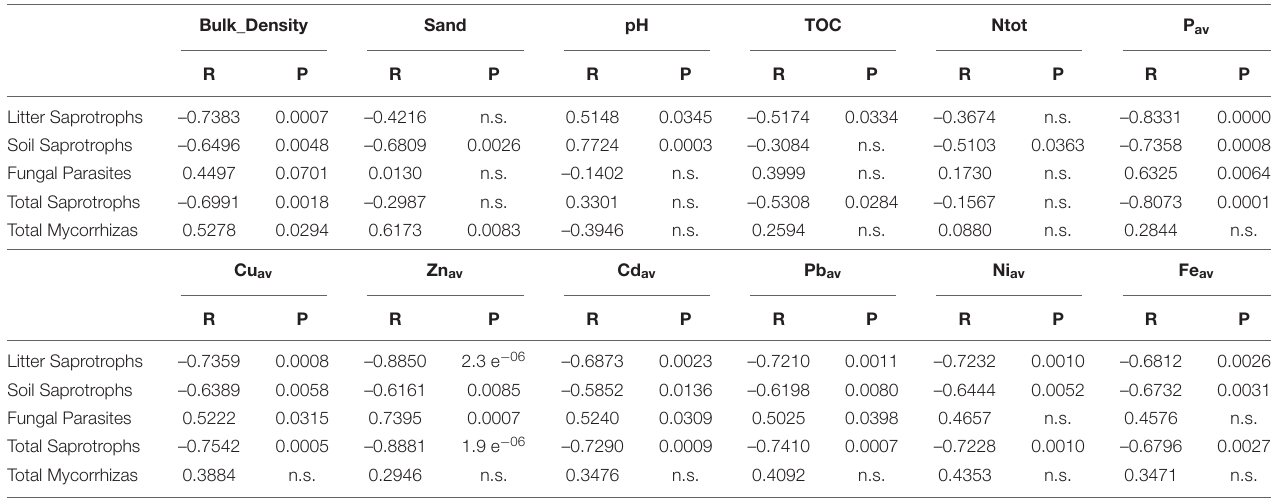
TABLE 6 | Pearson correlation between the abundance of the fungal guilds measured as reads number and the soil chemico-physical parameters.